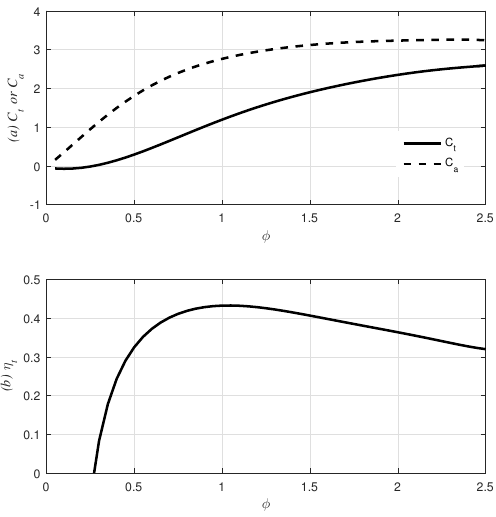
Figure 2. Turbine characteristics: ( a ) input and torque coefficients; ( b ) turbine